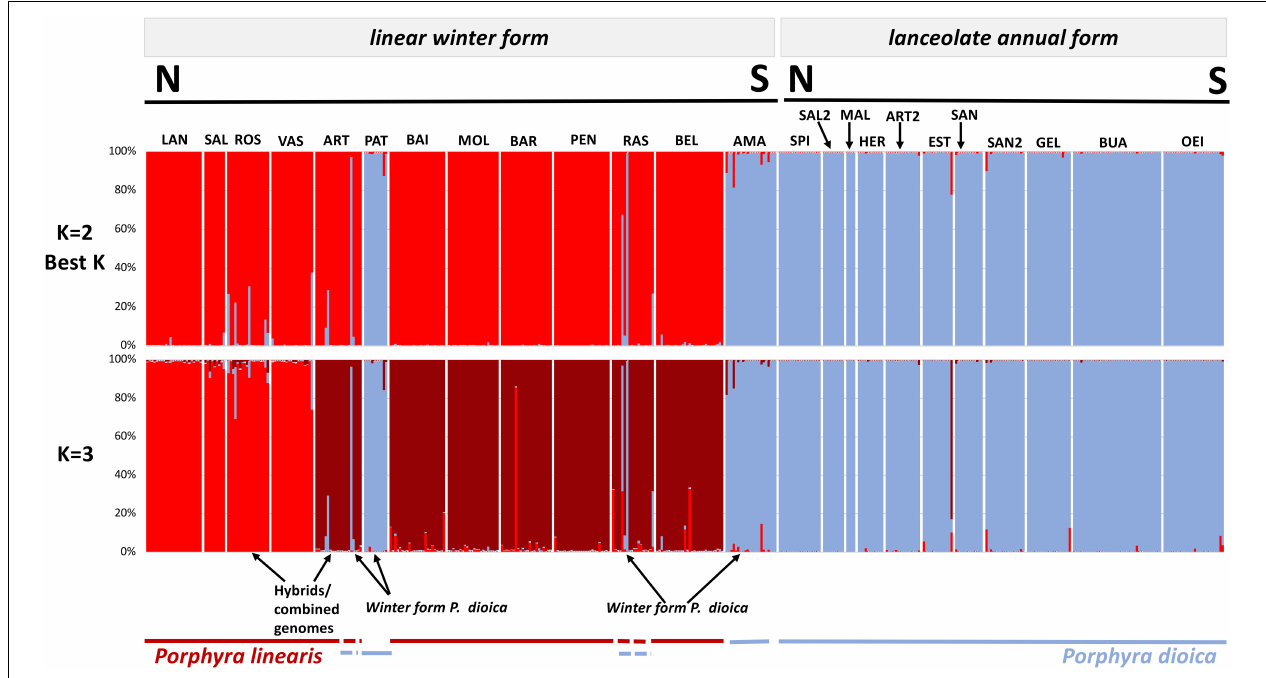
FIGURE 4 | Genome constitution of the 442 genotypes inferred by S TRUCTURE to 2 and 3 inferred clusters based in 10 microsatellite loci. A column represents each individual; different colors within columns indicate the maximum likelihood probability of belonging to different clusters. Blue colors are associated to P. dioica (either winter or annual) nuclear genomes and red colors are associated to P. linearis nuclear genomes. Population codes in Table 1 .